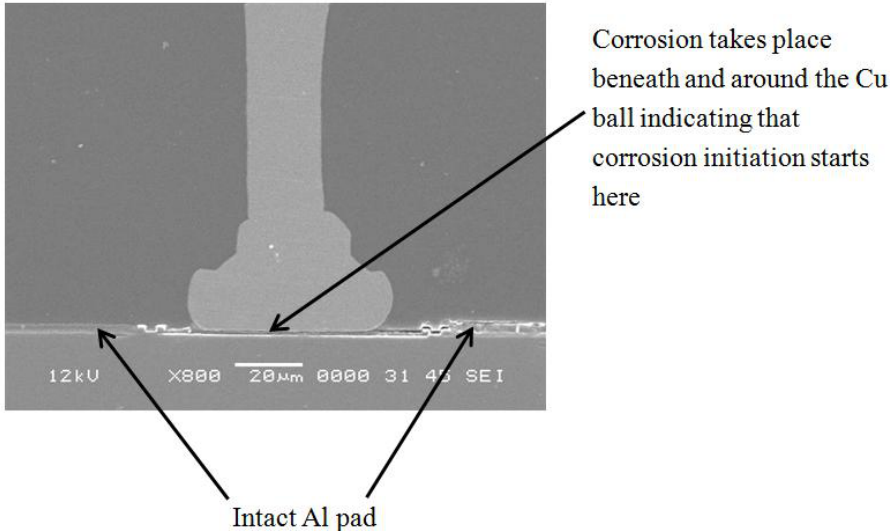
Figure 5. Cross-sectional analysis of Cu ball on Al pad revealing corrosion initiation beneath the Cu